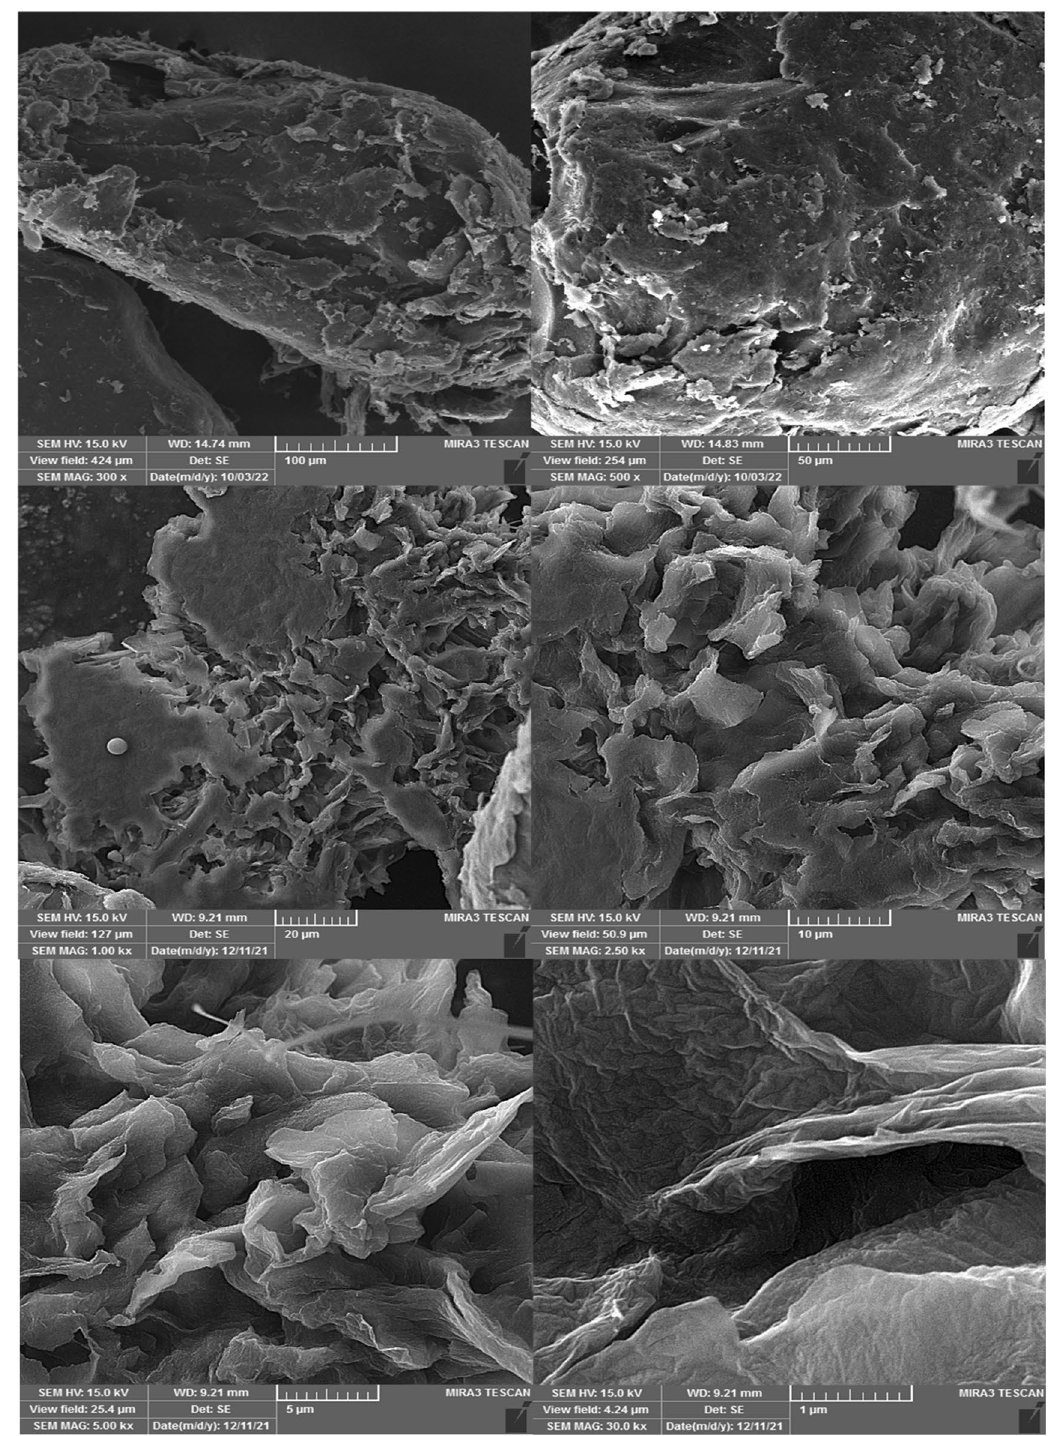
Figure 8. The SEM images of the synthesized TiO 2 @PVA nanocomposite with different